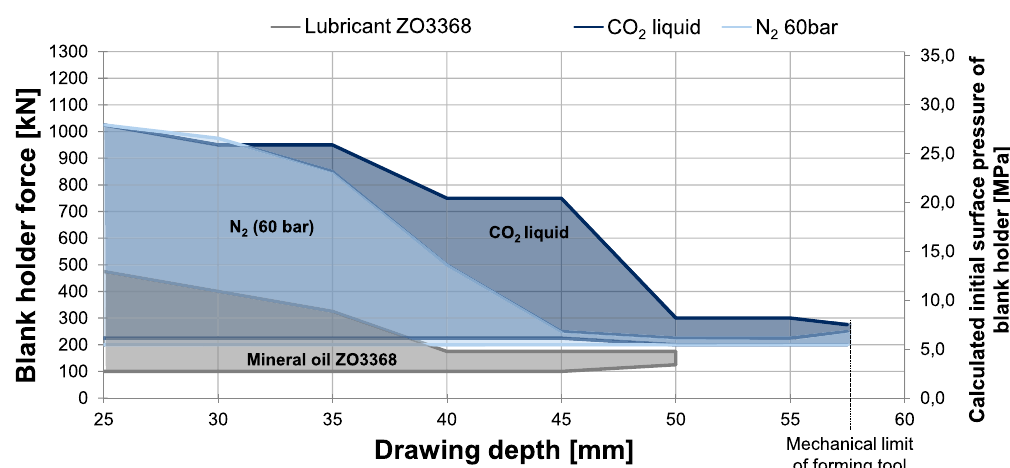
Fig. 18. Process windows for deep drawing of a rectangular cup using different lubrication systems [13].